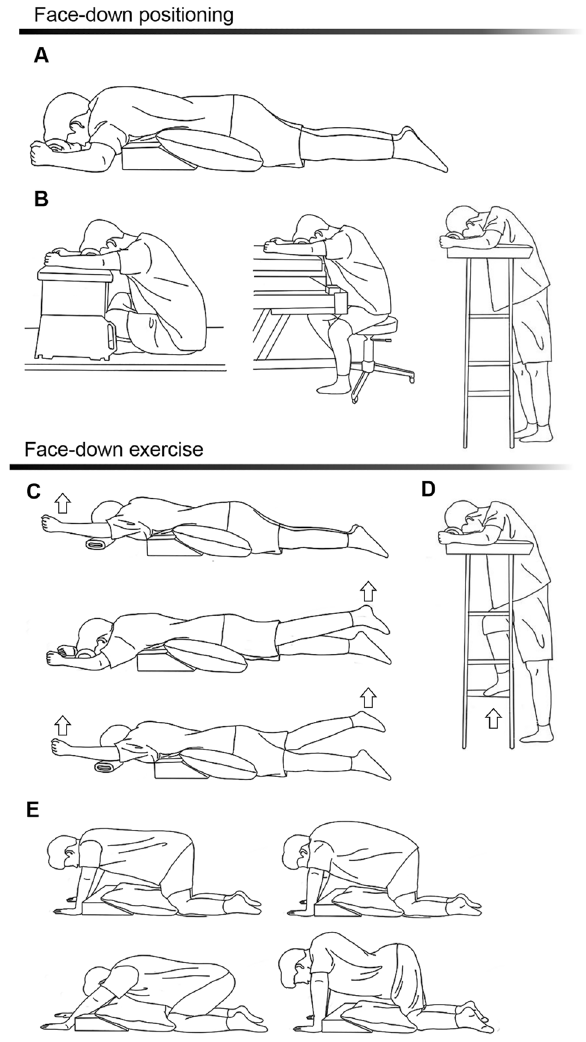
Figure 2. Patient Instructions for Proper FDP and Rehabilitation Exercise. ( A ) Basic FDP. Use a towel or pillow to support the forehead and reduce the load on the back neck. Use a pillow to support the upper body from the chest to the pelvis and keep them higher than the legs to reduce lower back load. Adjust pillow positioning to support the forehead and abdomen. ( B ) Modified FDP using a table (left), chair (middle), and walker (right). Maintaining only the basic FDP could put much strain on the neck, shoulders, and waist. Therefore, while maintaining basic FDP, modified FDP was occasionally applied, so that the physical stress is not concentrated in specific areas of the body. The following instructions were provided: (Left) Put a small table on the bed, and place the head on it. Use a towel or pillow to support your forehead, and place your arms naturally on either side of your head. (Middle) Adjust the height of the bed, place the chair at bedside, and maintain FDP while sitting. (Right) Adjust the height of the walking aids, and assume FDP in a standing position. Adjust the height of the bed, table, or walker properly, and use a pillow or towel under the forehead to avoid excessive neck or back bending. ( C ) Limb exercise in the basic FDP. Slowly lift one arm to shoulder level for 5–10 s, before putting it back into place. Slowly lift one leg to the level of the buttock with your straightened for 5 to 10 s, before put it back into place, to avoid straining the waist. The postures are then combined, such that the arms and legs are crossed. Each posture was maintained for 5 to 10 s and performed 10 times twice. This exercise stretches and strengthens the limbs and lower back muscles. ( D ) Limb exercise in standing FDP with walking aids. Walk slowly, and try not to lose balance and fall down. Each side was repeated 10 times for two to three sets. This exercise strengthens the muscles in the back and lower extremities. ( E ) Exercise in the hand and knee position: back stretching (left two rows), back bending, and forward bending (right two rows). With the head face down, take the hand-and-knee position. Sit back with the hips touching the heels with head maintained. Feel the stretch on your arms, shoulders, back, and buttocks; hold the position for 10–15 s; and then return to the hand-and-knee position. Repeat this for 5 to 10 times. Slowly lift the waist, making the spine round like a dome, then slower lower it, making the spine U-shaped. Maintain each posture for 5 to 10 s and performed 10 times twice. This exercise relaxes the shoulders, back, and spine, and strengthens the back muscles. The entire exercise session was repeated three times daily. During exercise, the position of the head should be maintained with the floor. This figure is created by Hani Yun from the Samsung Medical Information & Media Services, Samsung Medical